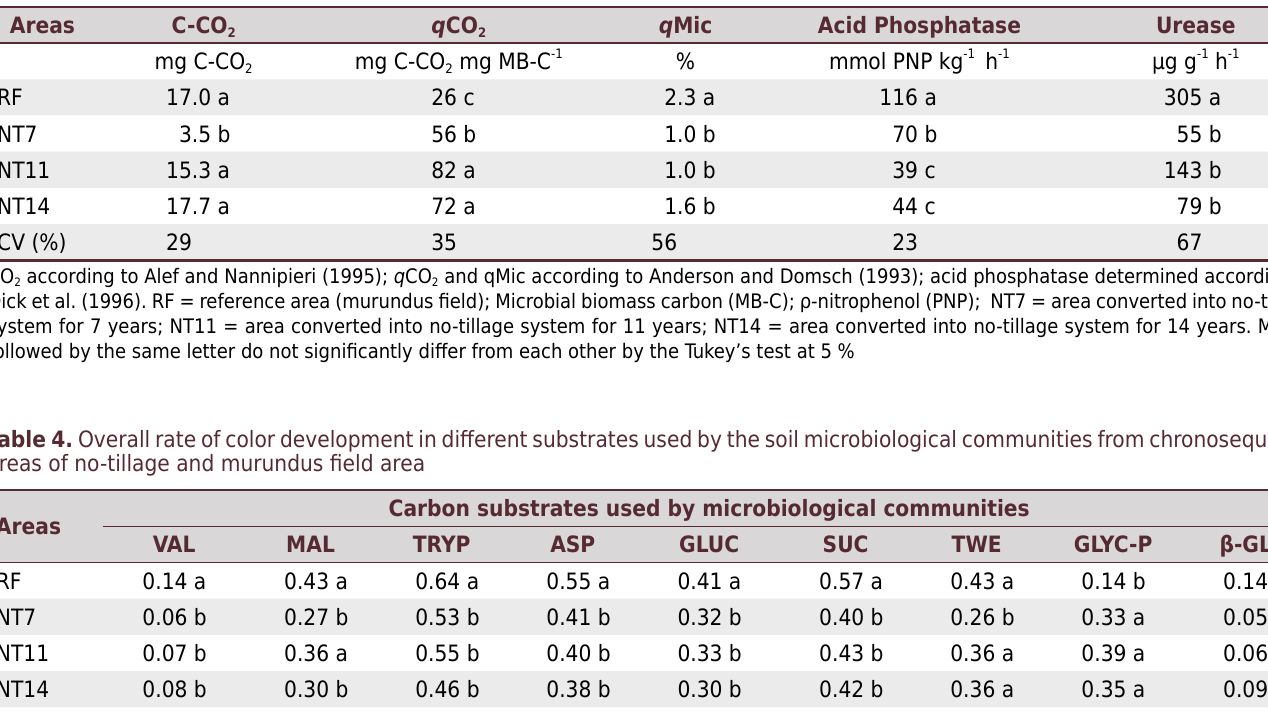
without anthropic intervention showed higher activity in most of the carbon substrates, except for glucose-P. In the clustering analysis, the physiological profiles revealed the area with the shortest conversion time (NT7) was the most distinct from the other areas. Conversely, results showed that the area with the longest conversion time (NT14) was the closest to the natural ecosystem (Figure 2).